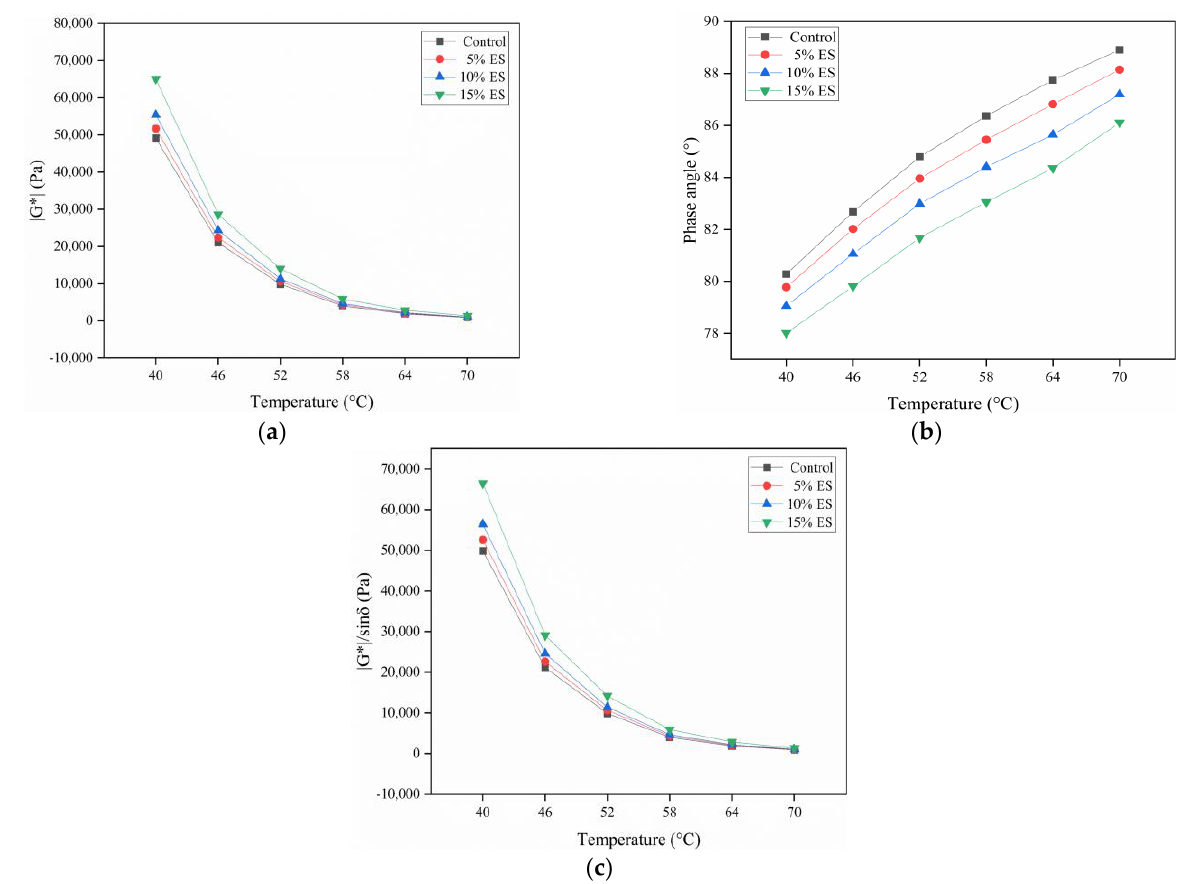
Figure 7. Temperature sweep results of 5, 10, and 15% eggshell powder bitumen: ( a ) complex shear modulus; ( b ) phase angle; ( c ) rutting factor.